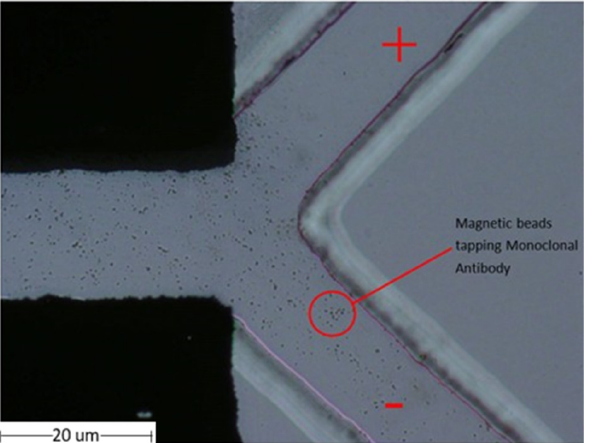
Figure 9. Magnetic particles flow on a monoclonal antibody in microstructure flow channel with microfluidic chip. Table 5. Separation of the sample magnetic particles on monoclonal antibody in microstructure flow channel with microfluidic and MWCNT-microfluidic chip.